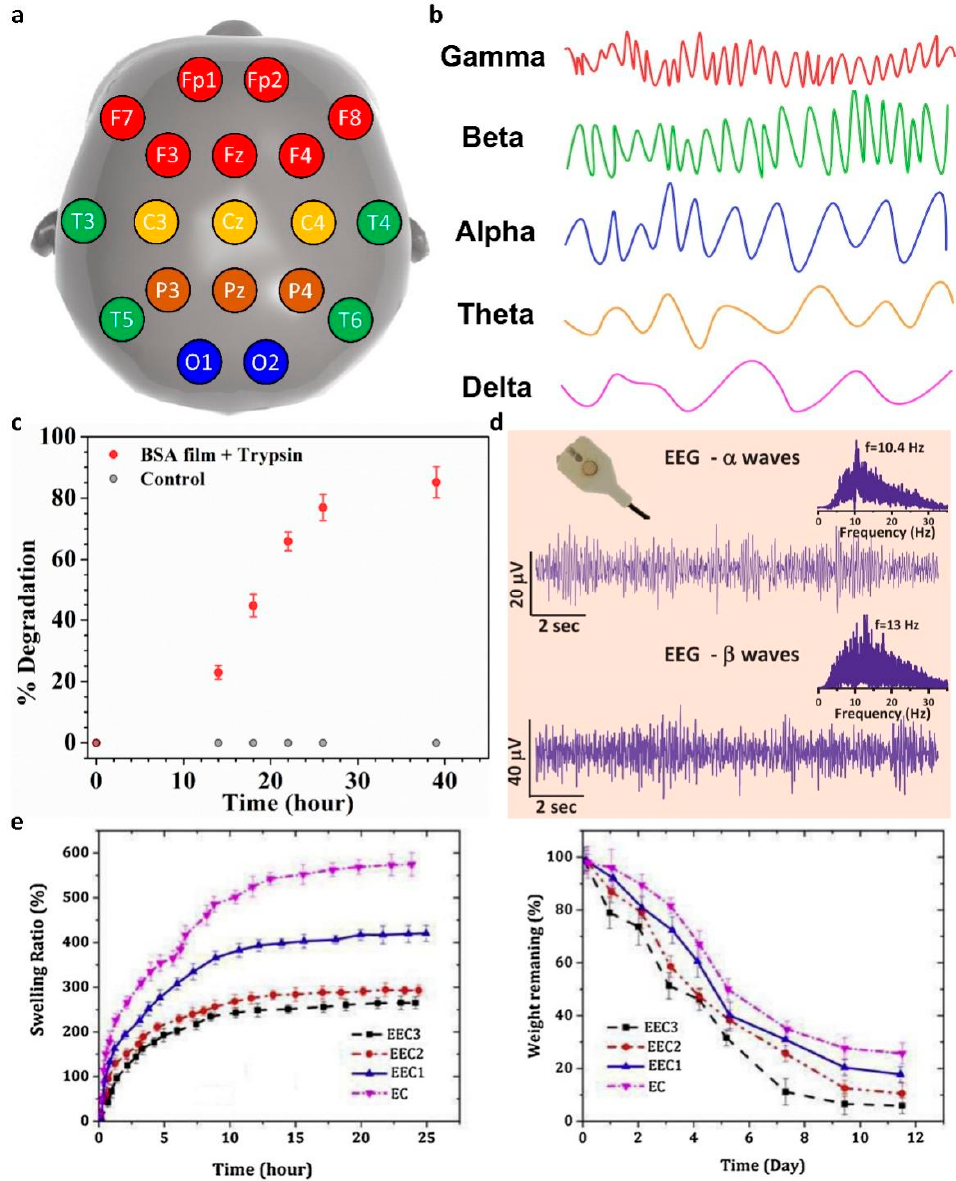
Figure 7. ( a ) Schematic of the international 10–20 EEG electrode system method; ( b ) EEG waveform classified by the power spectral method; ( c ) degrading rate of BSA film in a trypsin condition; ( d ) EEG waveform of alpha and beta waves (adapted from [115] with permission from John Wiley and Sons); ( e ) swelling rate and degradation rate of conduct polymer coatings (adapted from [116] with permission from the Elsevier B.V.).